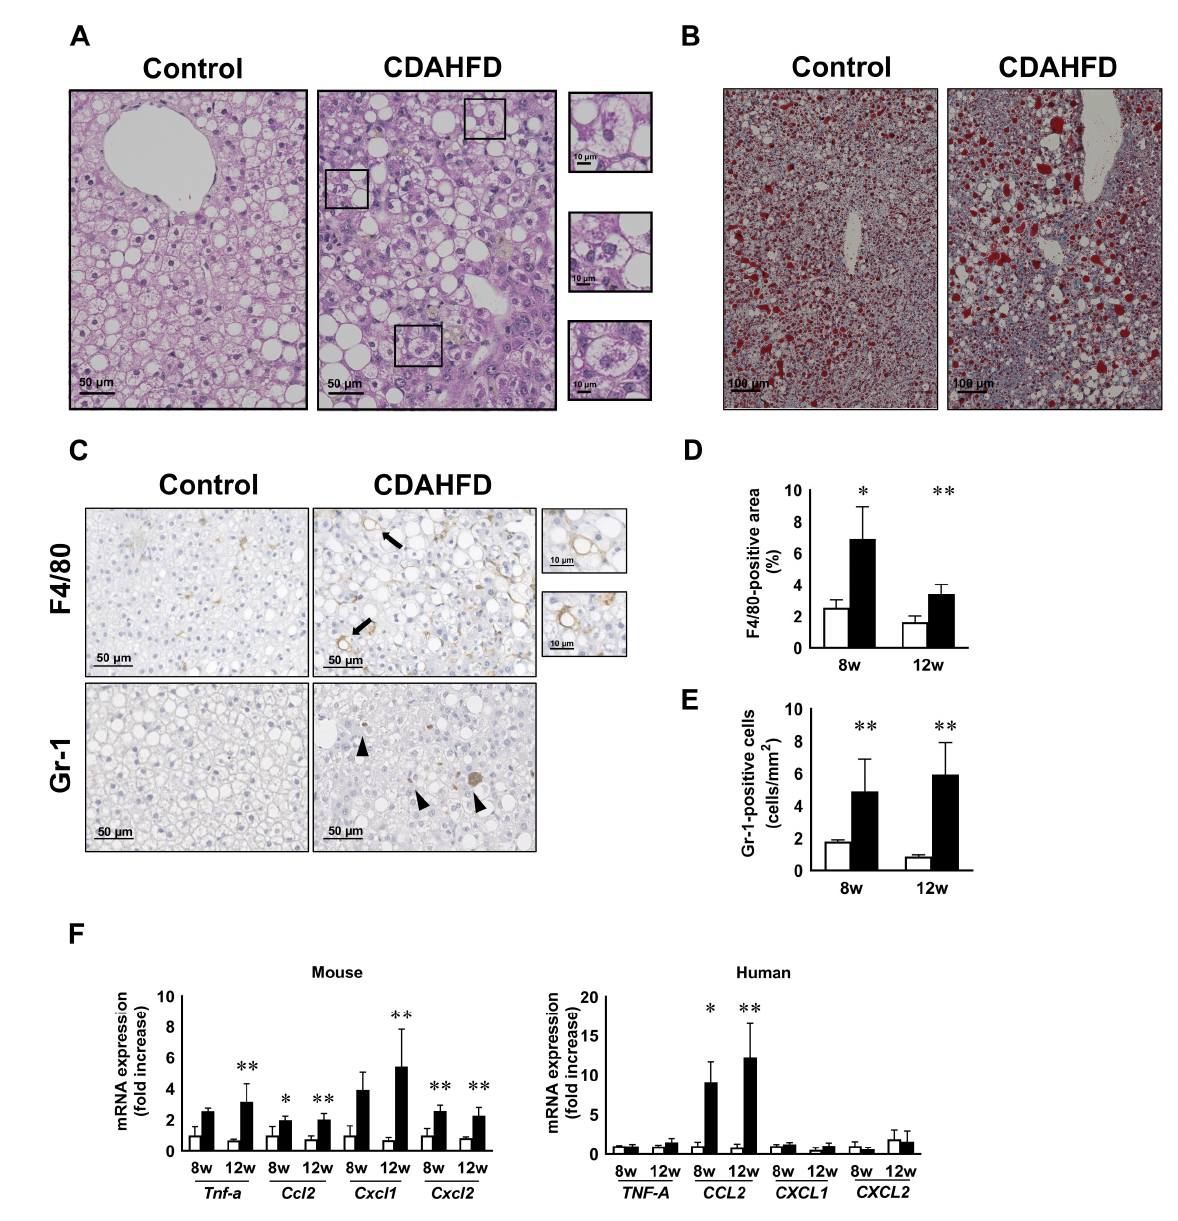
Figure 2. Degeneration of h-heps and inflammation in human chimeric mice after CDAHFD feeding. Representative images of H&E staining ( A ) in the liver of mice fed a control diet or CDAHFD at week 12. Scale bar: 50 µ m. Areas in the squares in the CDAHFD group were magnified. Ballooning hepatocytes and Mallory–Denk-body-like aggregates were observed. Scale bar: 10 µ m. Representative images of Oil Red O staining ( B ) in the liver of mice fed a control diet or CDAHFD at week 12. Scale bar: 100 mm. Representative images of immunostaining with F4/80 or Gr-1 antibody in the liver at week 12 of mice fed a control diet or CDAHFD ( C ). Scale bar: 50 µ m. Areas in the squares of F4/80 in the CDAHFD group were magnified. Scale bar: 10 µ m. Gr-1-positive cells were shown by arrows. The ratio of the F4/80-positive area ( D ) and number of Gr-1-positive cells in the liver of the control and CDAHFD groups at 8 or 12 weeks ( E ). Values for the F4/80-positive